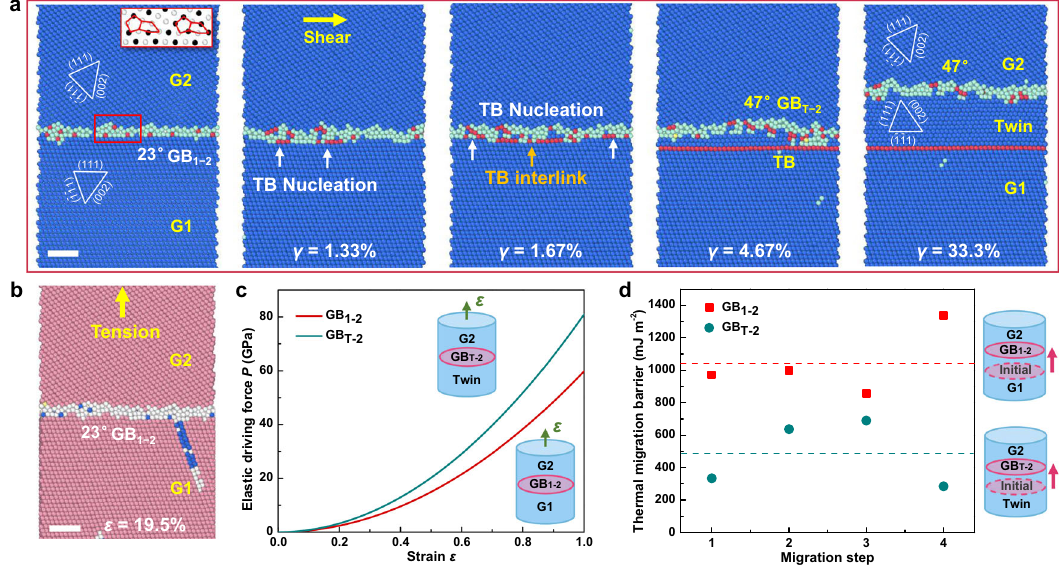
Fig. 3 Microstructural origin of the self-adjustment of GB mobility. a MD simulation snapshots demonstrating the atomic-scale structural adjustment during the twinning-assisted GB transformation under shear loading. The Au bicrystal constructed in MD simulations, containing a fl at 23° tilt GB. The inset presents a regular structure unit of the GB. Nucleation of embryonic TB segments associated with the local rearrangement of atoms at GB 1 – 2 , as indicated by the white arrows ( γ = 1.33%). Interlink of TB segments along the GB with further TB nucleation events ( γ = 1.67%). Complete transformation from GB 1 – 2 to GB T-2 via the interlink of twin segments ( γ = 4.67%). The newly formed GB T-2 migrated upward while TB remains static in subsequent shear loading ( γ = 33.3%). b The same bicrystal deformed under axial tensile loading, which is dominated by elastic deformation of the grains and dislocation emission with negligible GB migration. c Theoretical elastic driving force P for the migration of GB 1 – 2 and GB T-2 as a function of the applied normal strain with respect to the GB plane. d Comparison between the thermal migration barriers of GB 1 – 2 and GB T-2 measured from four consecutive migration steps along the GB normal direction, with a migration distance of one atomic layer (approximately 0.3nm) per unit step. The average values of migration barriers of GB 1 – 2 and GB T-2 from these migration steps are highlighted by the red and cyan dotted lines, respectively. Atoms with FCC, HCP and disordered structures were coloured in blue, red and cyan in ( a ); and in pink, blue and white in ( b ). All scale bars: